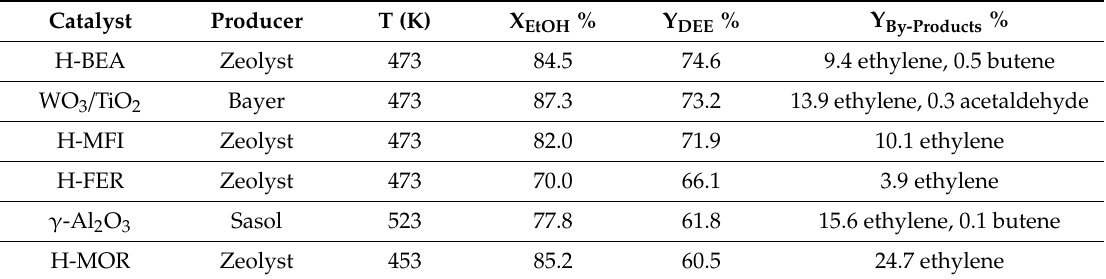
Table 3. Maximum DEE yields obtained on the di ff erent acid catalysts, and the byproduct yields. Catalyst Producer T (K) X EtOH % Y DEE % Y By-Products % H-BEA Zeolyst 473 WO 3 / TiO 2 Bayer H-MFI